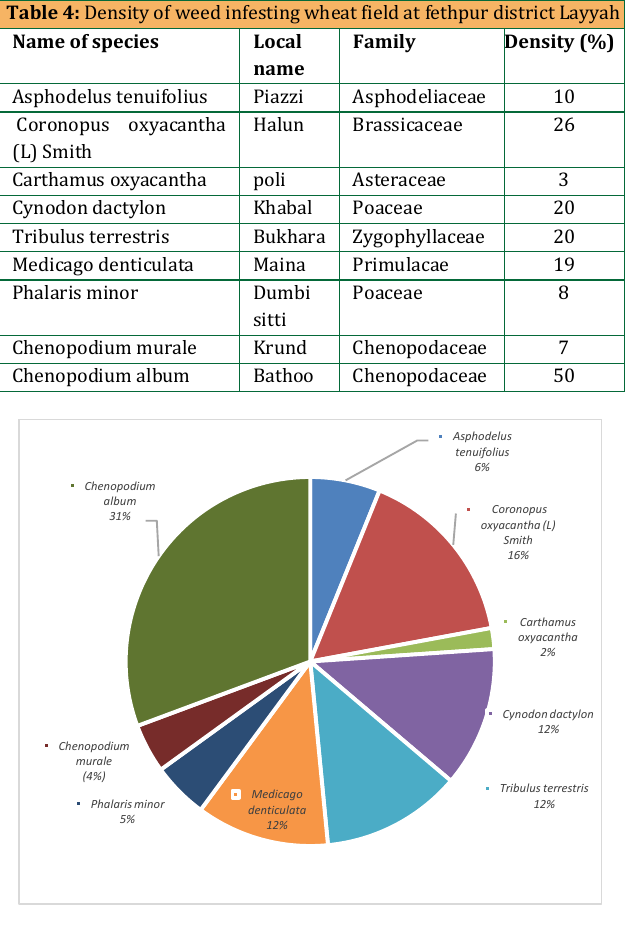
Figure 4: Density of weed infesting wheat field at fethpur district